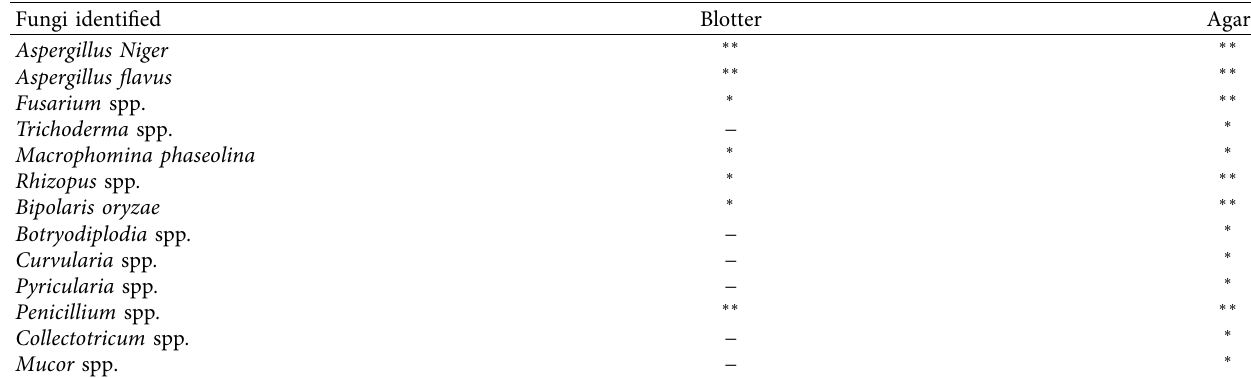
Table 5: Fungi isolated and identifed using diferent methods (blotter and agar).